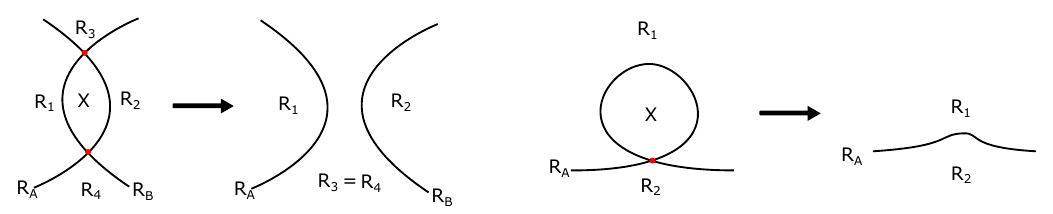
Figure 13 . Wilson line crossings that can be undone. Left: double crossing of two lines. Right: self-crossing of a single